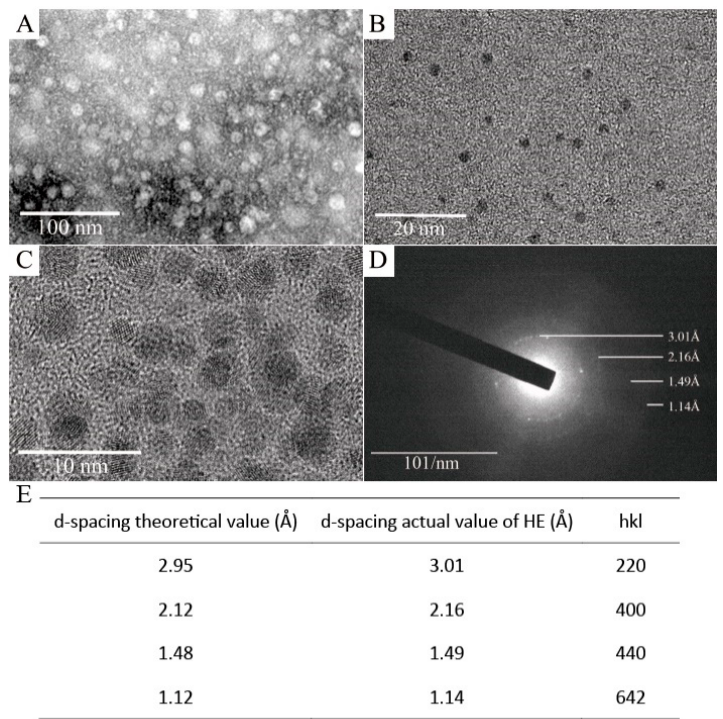
Figure 4. ( A ) Transmission electron microscopy (TEM) image of magnetoferritin of HE stained with 1% uranyl acetate. ( B ) TEM image of magnetoferritin of HE without staining. ( C ) High-resolution transmission electron microscopy (HRTEM) image of magnetoferritin of HE. ( D ) Selected area electron diffraction (SAED) image of magnetoferritin of HE. ( E ) Theoretical and actual d-spacings for magnetoferritin of HE.